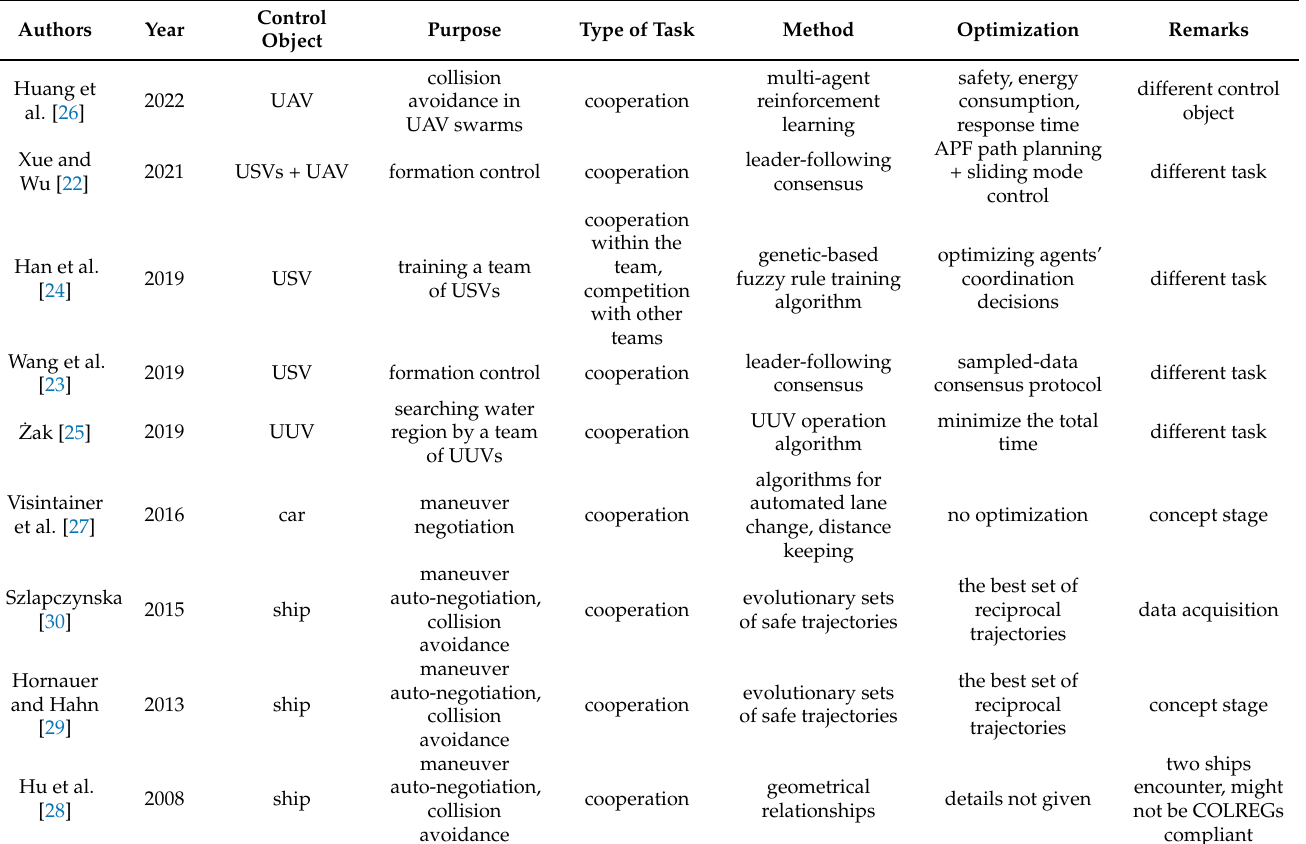
Table 5. Multi-agent systems for ships and unmanned